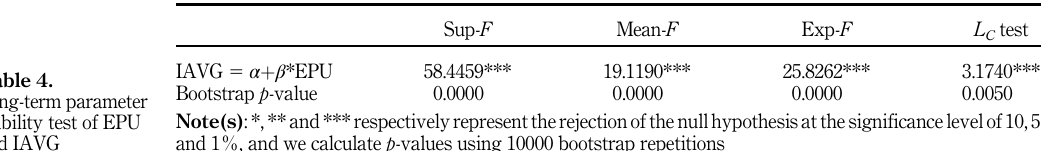
Table 3. Short-term parameter stability test of EPU and IAVG